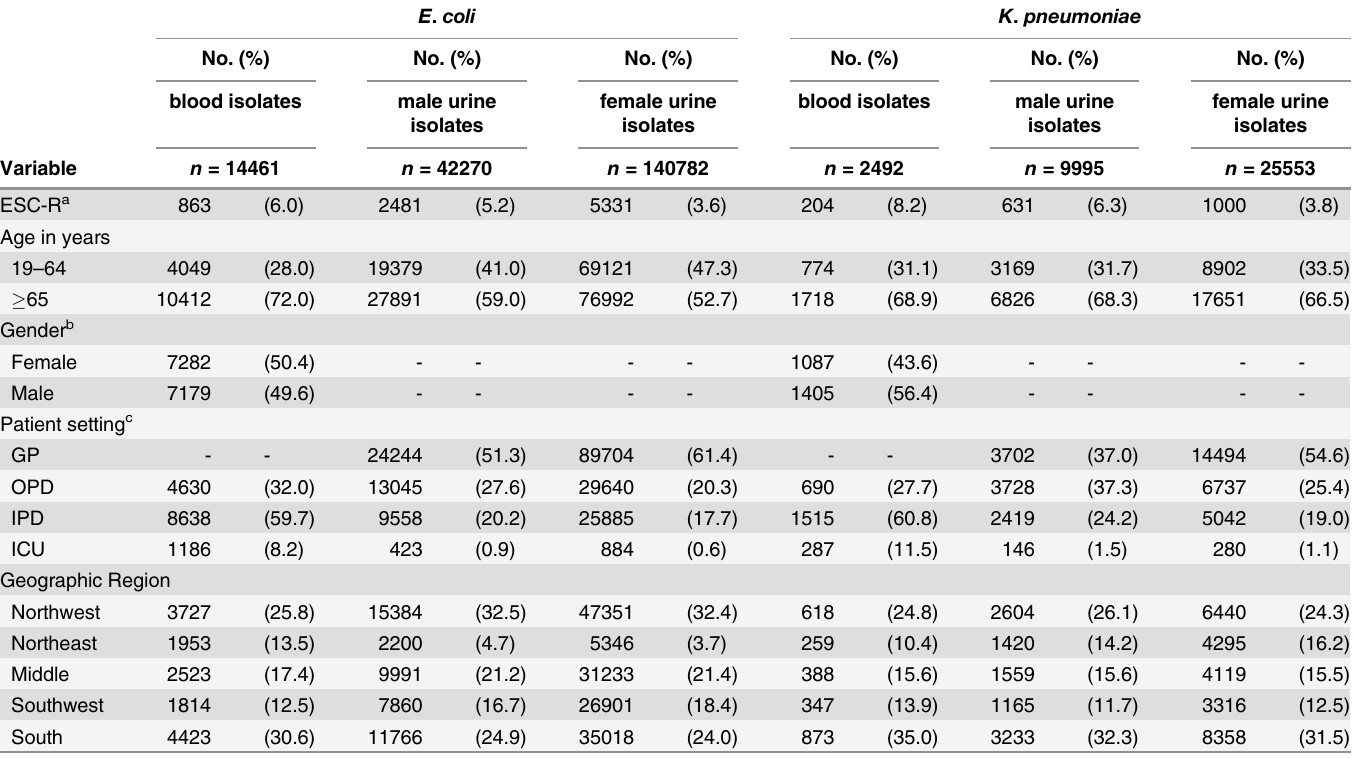
Table 1. Background characteristics for Escherichia coli and Klebsiella pneumoniae isolates, ISIS-AR The Netherlands, 2008 –